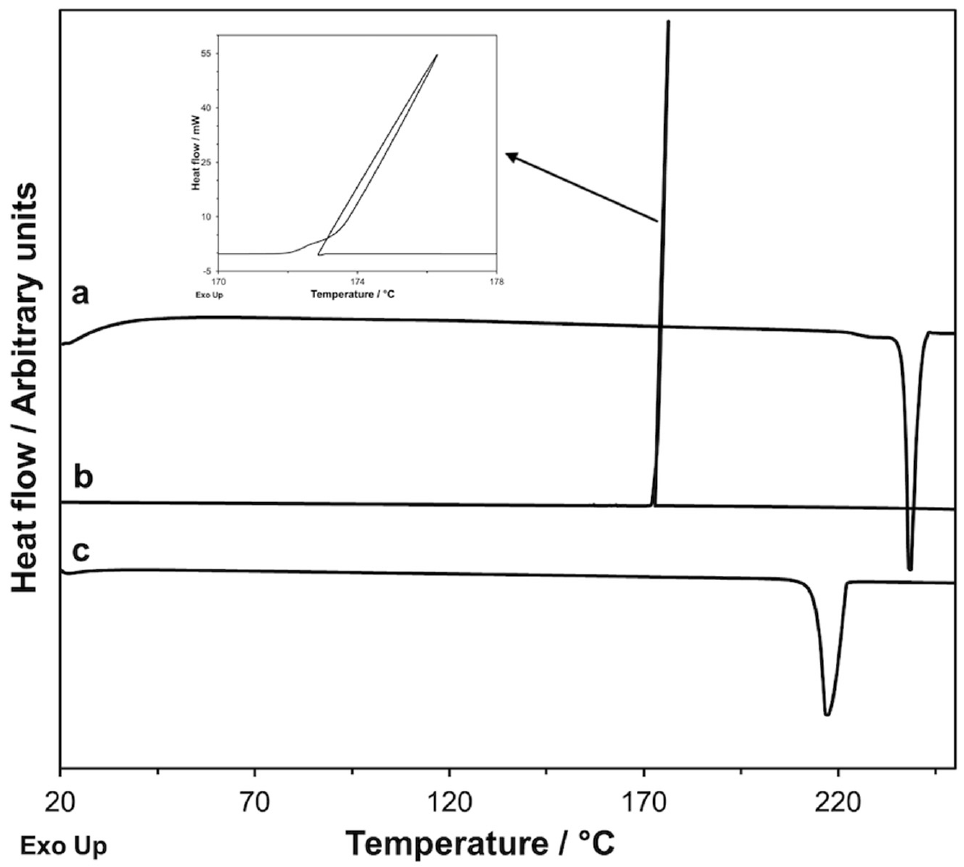
Figure 7. DSC curves recorded on a GS sample: first heating at 10 K · min − 1 ( a ), cooling at 2 K · min − 1 (( b ) and insert), and second heating at 10 K · min − 1 ( c ).